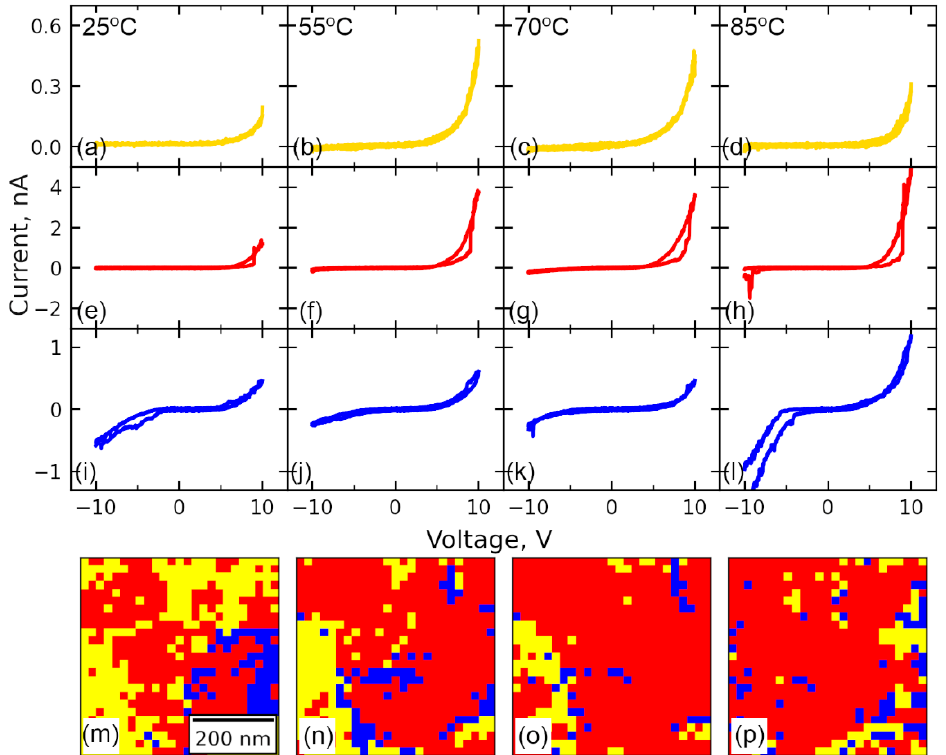
Figure 3. Typical IV dependencies: ( a – d ) unipolar, ( e – h ) unipolar with RS, ( i – l ) bipolar, and ( m – p ) their distributions at various temperatures: ( a , e , i , m ) 25 °C, ( b , f , j , n ) 55 °C, ( c , g , k , o ) 70 °C, ( d , h , l , p ) 85 °C.